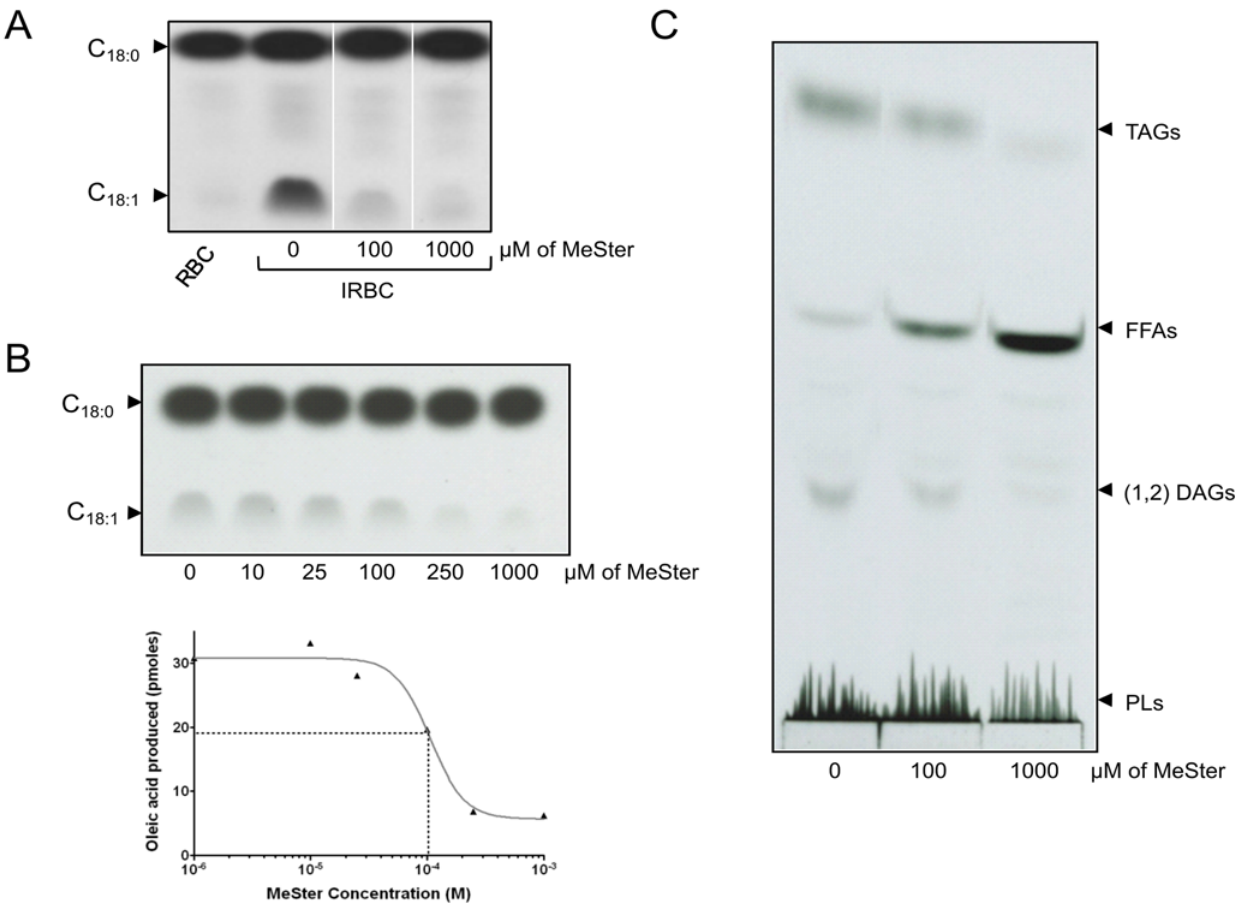
Figure 6. Inhibition of oleic acid synthesis by methyl sterculate. (A) P. falciparum 3D7-infected RBC were either left untreated or were treated for 1 hr with MeSter concentrations corresponding to 1 6 or 10 6 the IC 50 value, and subsequently labeled with [ 14 C]-stearic acid for an additional 4 hrs. Non-infected red blood cells (RBC) were used as a negative control. Following extraction, FAs were methyl-esterified and equal volumes were loaded on a TLC plate and resolved as described in the Experimental Procedures. (B) Inhibition of the stearoyl-CoA desaturase activity in parasite lysates. Crude extracts (500 m g total protein) were preincubated for 10 min at 37 u C with 2 mM NADPH, in the presence of increasing concentrations of MeSter as indicated, prior to the addition of [ 14 C]-stearoyl-CoA. After an additional 5 min incubation at 37 u C, FAMEs were extracted, methyl- esterified and equal amounts of radioactivity counts were loaded on a TLC plate. The upper panel corresponds to the autoradiogram and the lower panel represents the curve obtained after scrapping the OAME spots, illustrating the effect of MeSter on oleic acid production. (C) Effect of MeSter treatment on parasite lipid composition. P. falciparum IRBCs were treated or untreated with MeSter, corresponding to 1 6 or 10 6 the IC 50 value, for 1 hr. Parasites were subsequently labeled with [ 14 C]-stearic acid for an additional 4 hrs. Following extraction, the same amounts of radioactivity were loaded and neutral lipids were resolved as described in the Experimental Procedures. DAGs, diacylglyerols; FFA, free fatty acids; PLs, phospholipids; TAG,